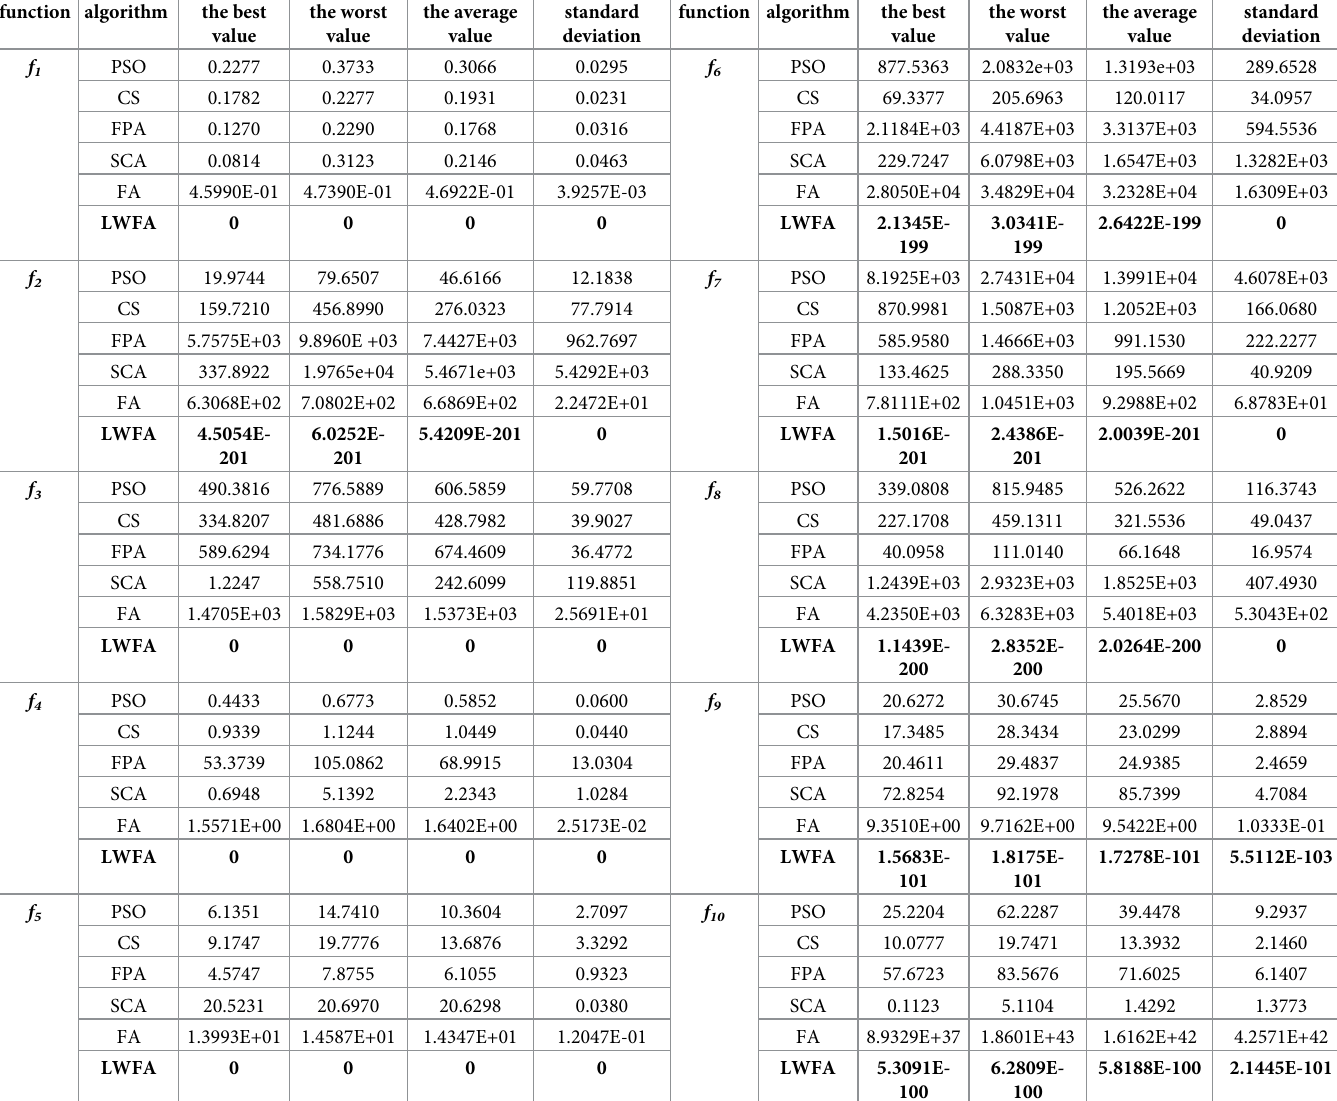
Table 7. The optimization result of 10 benchmark functions for different algorithms (D = 100). function